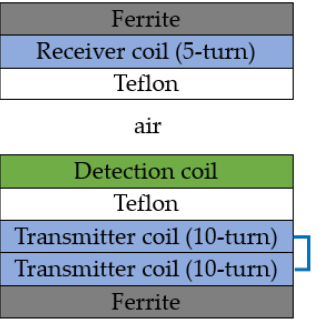
Figure 6. Side view of the wireless power transfer coils. Figure 7 depicts the wireless power transfer system and the proposed MOD system.